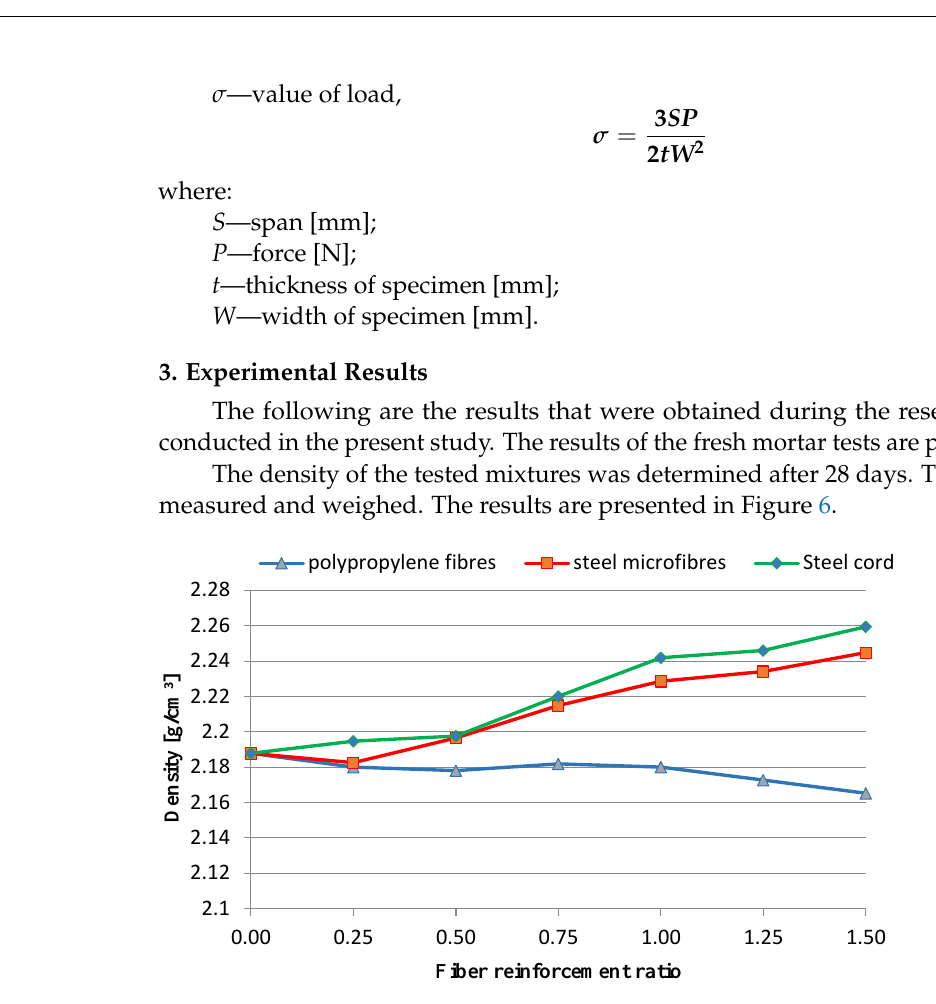
Figure 8. Flexural strength — first crack. Figure 9 presents the flexural strength values calculated in Equation (1). 0